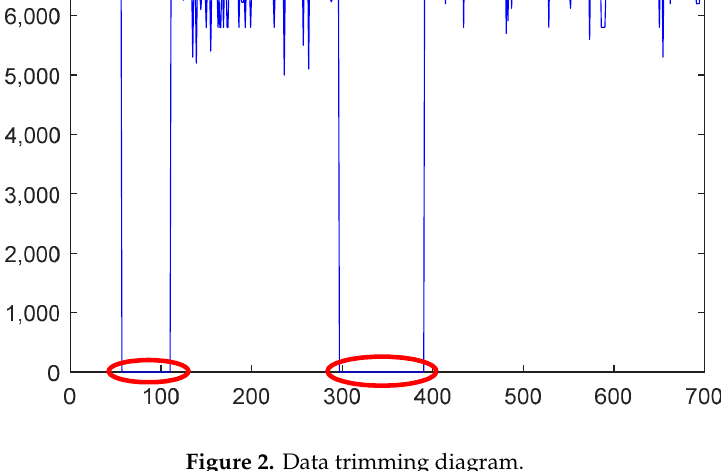
Figure 2. Data trimming diagram.